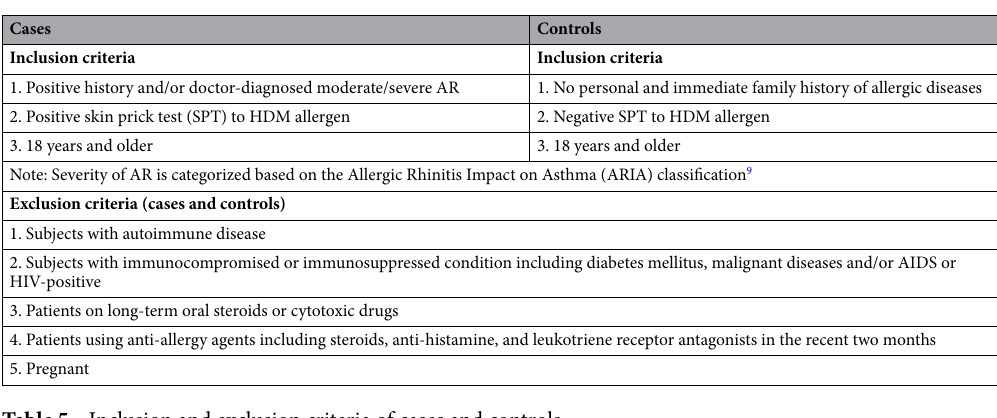
Table 5. Inclusion and exclusion criteria of cases and